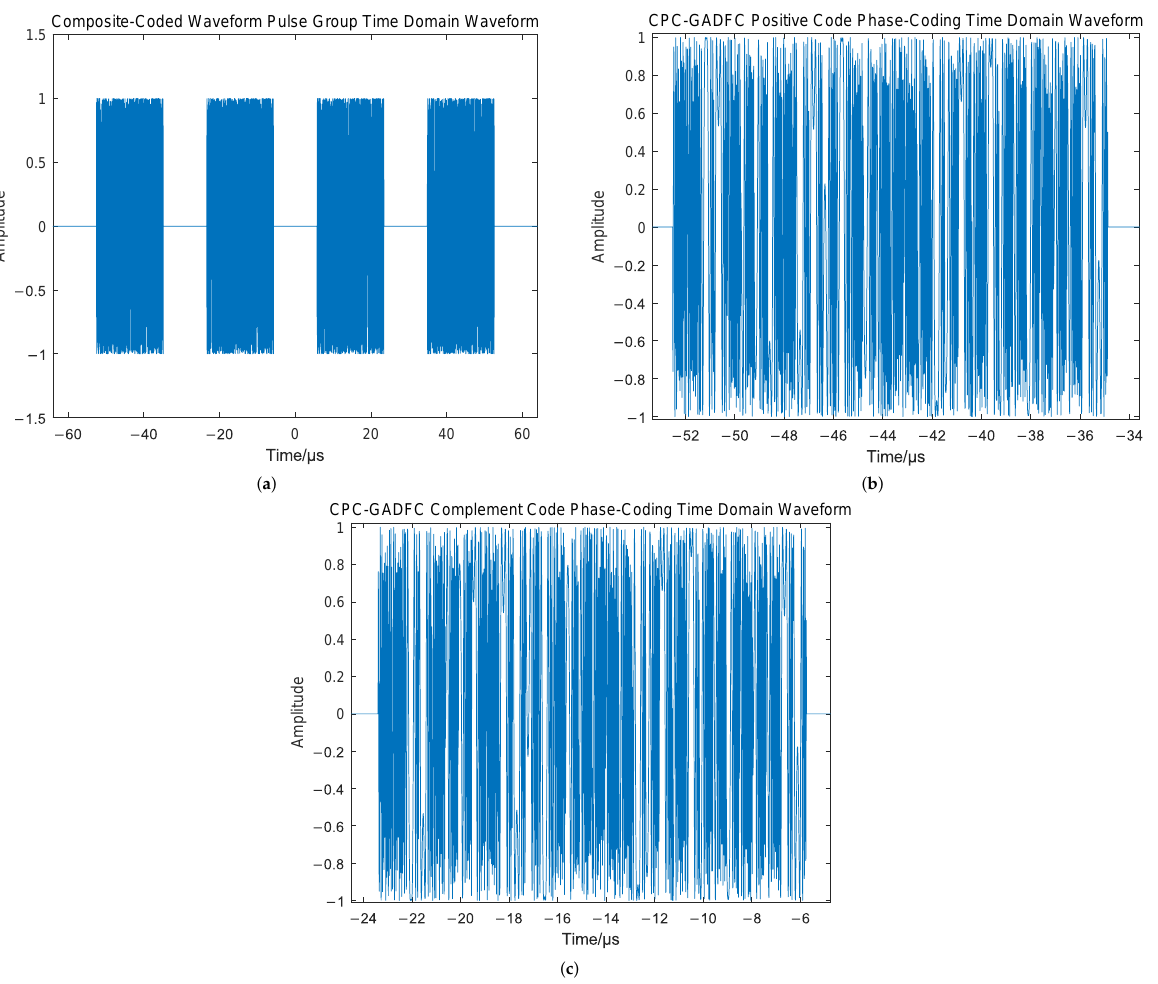
Figure 4. CPC-GADFC Joint Coding Radar Transmit Waveform, ( a ) a pulse group is alternately transmitted by positive code phase-coding and complementary code phase-coding, ( b ) the positive code phase-coding time domain waveform, ( c ) the complementary code phase-coding time domain